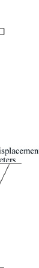
Figure 5. Displacement meters arrangement.